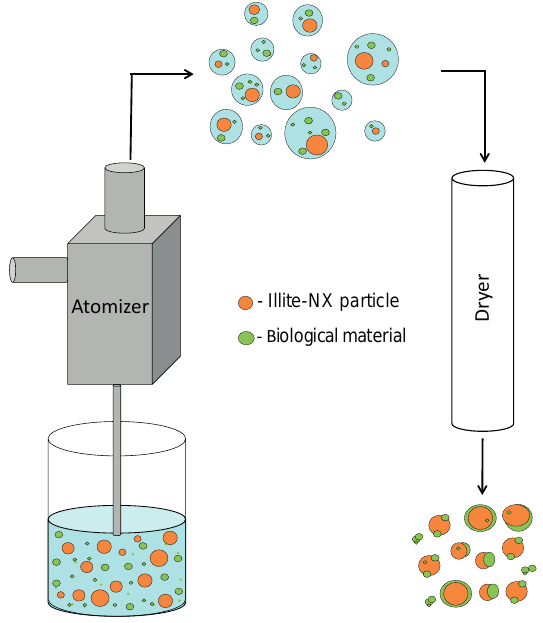
Figure 1. Schematic of the particle generation method used in this